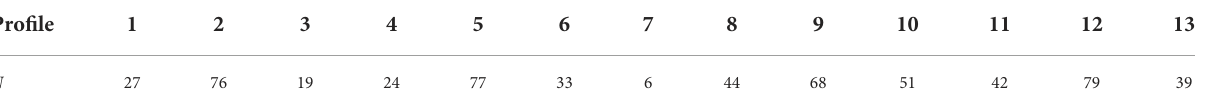
TABLE 2 Number of patients contained in each auditory profile.